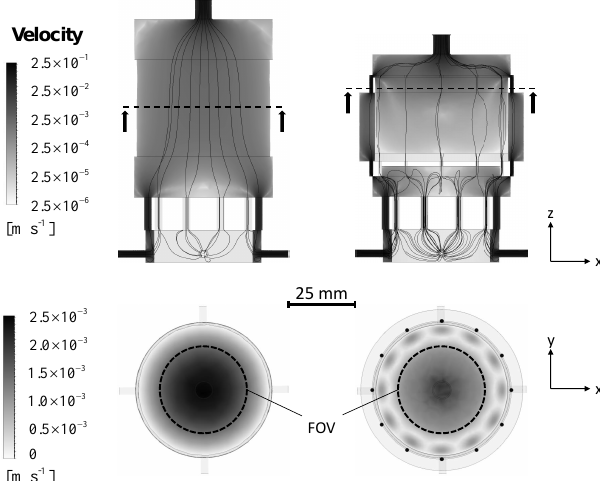
Figure 3. Vertical cross section of CFD-simulated airflow stream- line and velocity simulations for flow in the empty sample holder. A horizontal cross section of the scan area with the field of view (FOV) of the µ -CT is shown